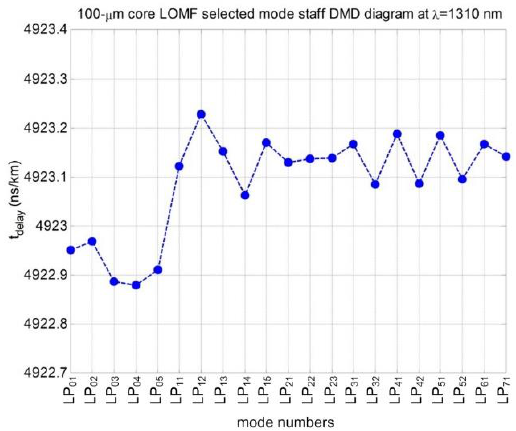
Figure 2. Differential mode delay (DMD) diagram, computed for selected guided modes in 100-μm LOMF at wavelength λ = 1310 nm.